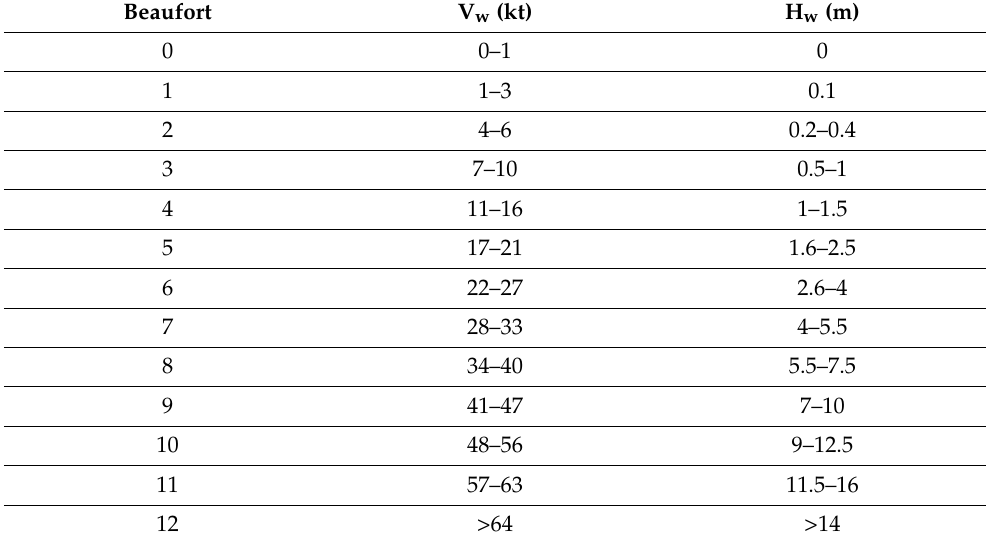
Table 2. Influence of wind intensity on waves’